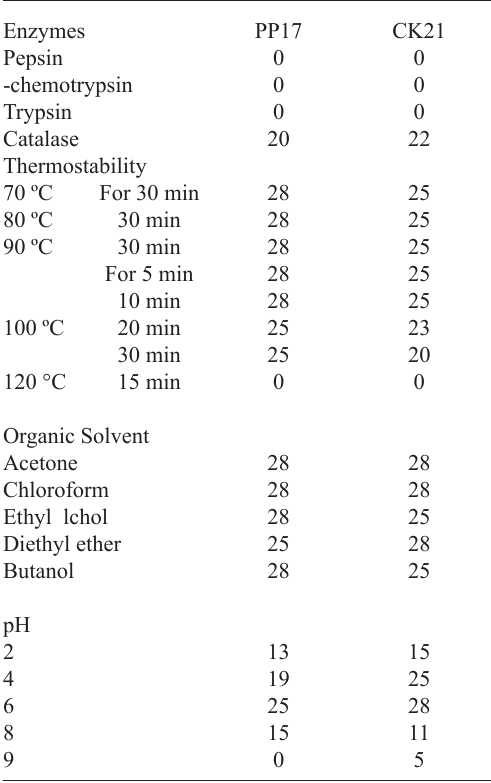
Table 5. Characterization of the inhibitory substance